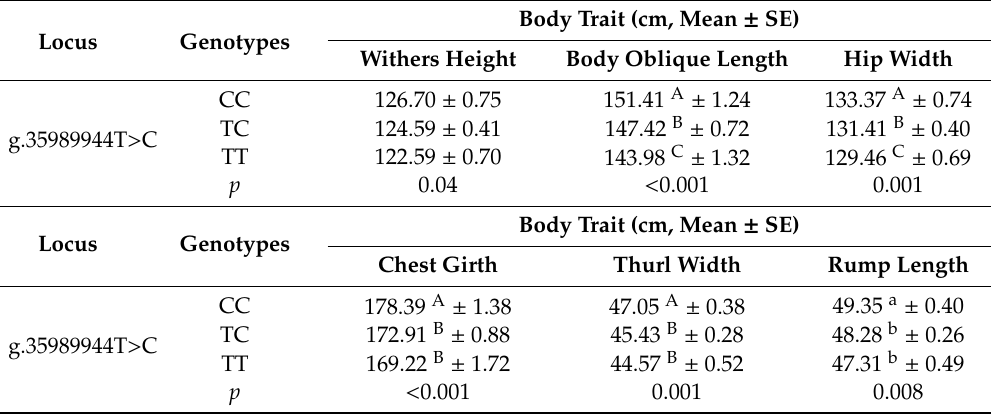
Table 6. Association between the KCNJ12 variation and cattle stature in Pinan (PN) cattle.